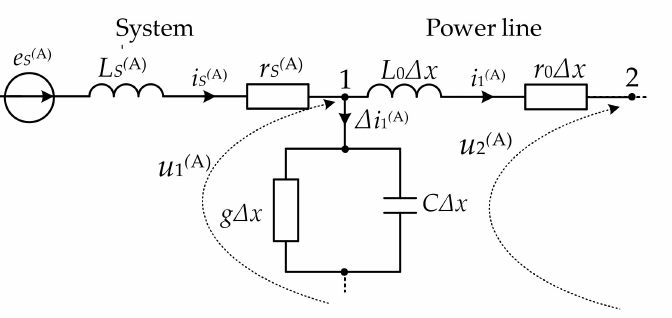
Figure 3. Computing diagram for voltage determination across a fictitious node at the line’s